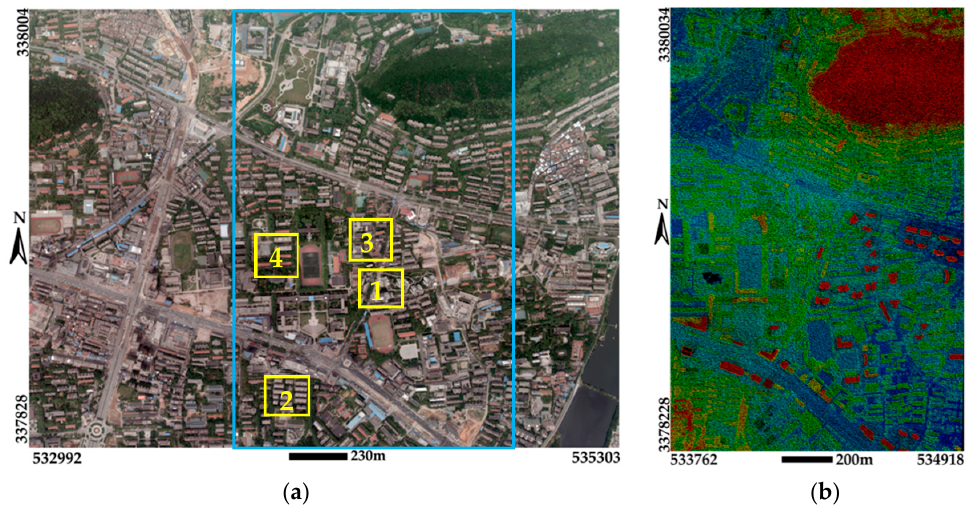
Figure 1. The test area and data source: ( a ) mosaicked image from the four UltraCamXp images where the cyan solid rectangle corresponding to the test area; and ( b ) new LiDAR point clouds .